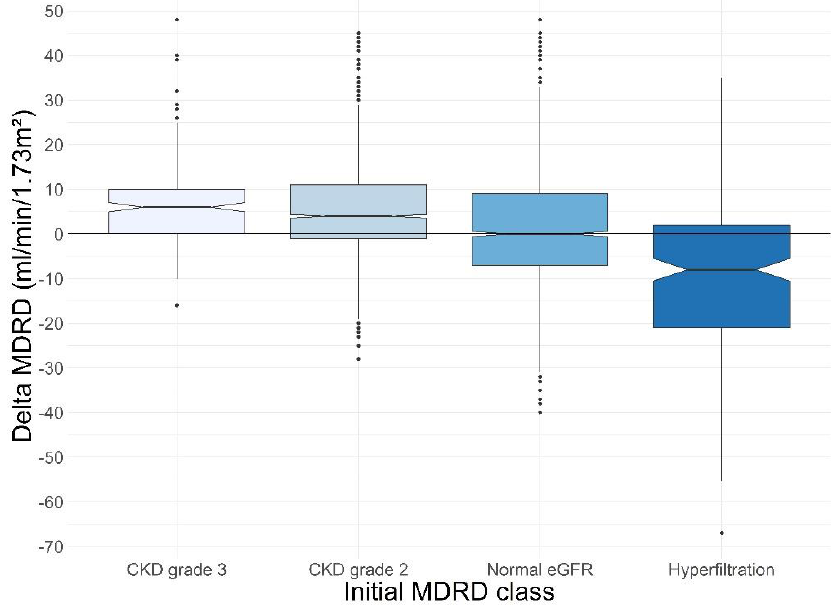
Figure 1. Distribution of delta MDRD according to initial MDRD class.